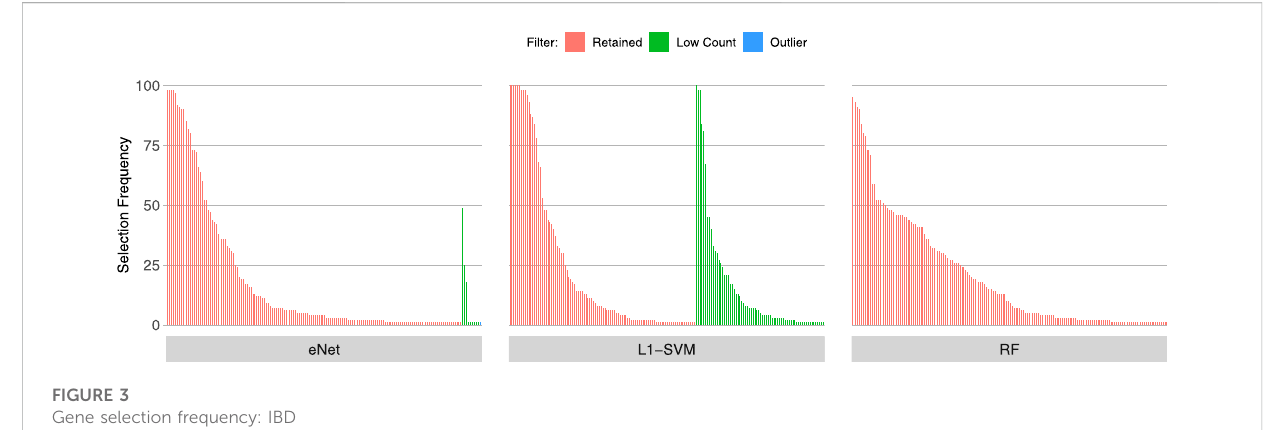
FIGURE 3 Gene selection frequency: